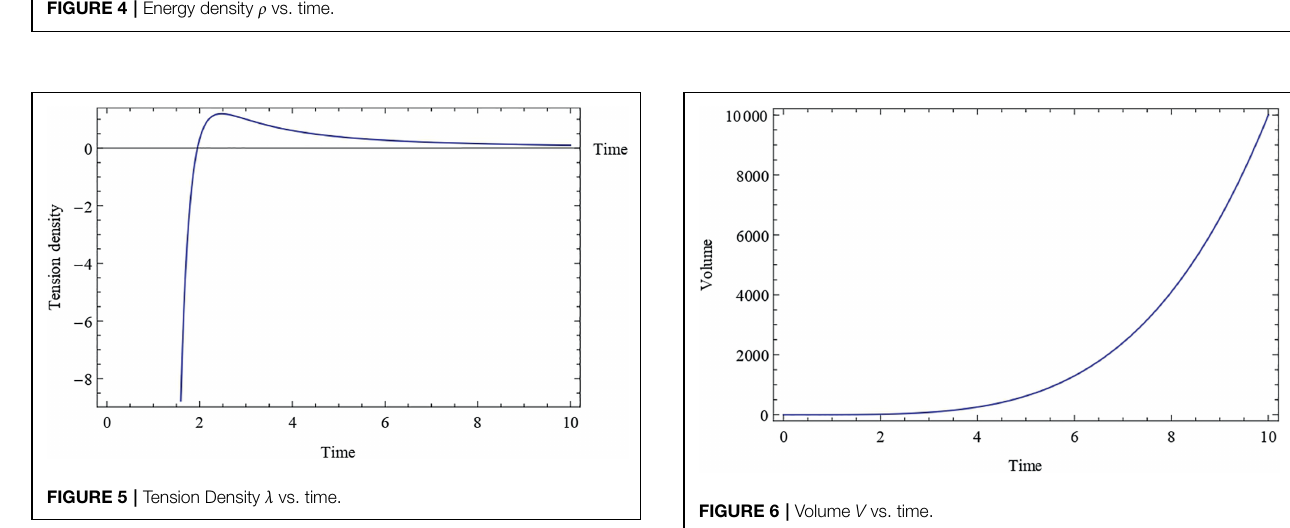
FIGURE 6 | Volume V vs. time.